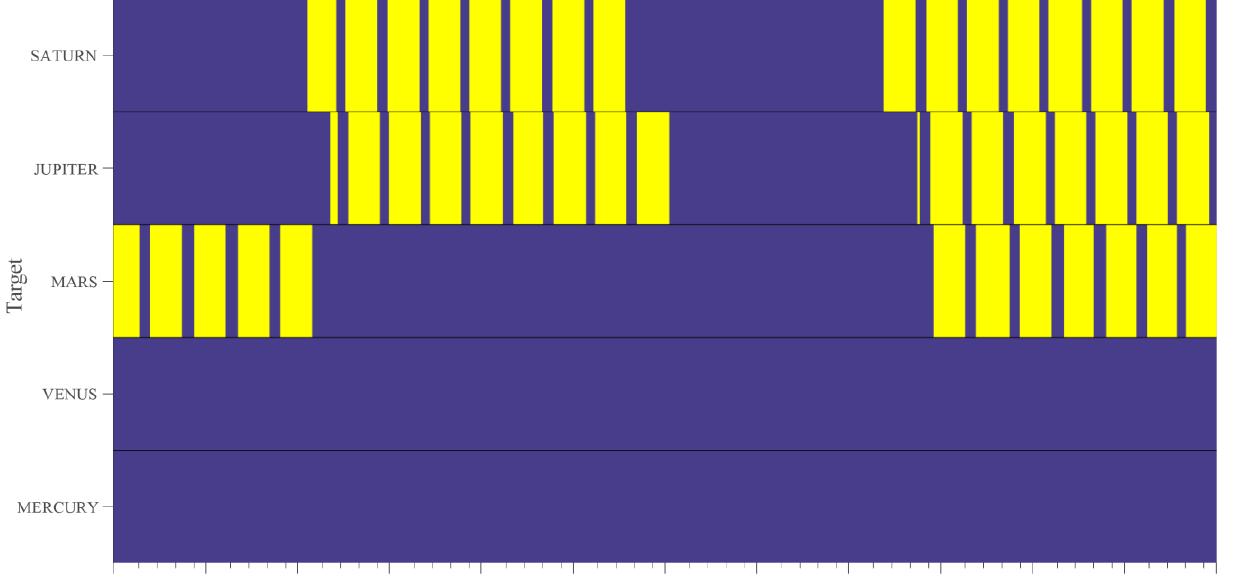
Figure 4. Observation windows from 1 January 2021 to 31 December 2022. Yellow areas denote the time during which the targets are observable, while dark blue areas indicate the time during which the targets cannot be observed. The horizontal axis represents UTC time and the vertical axis is the target.